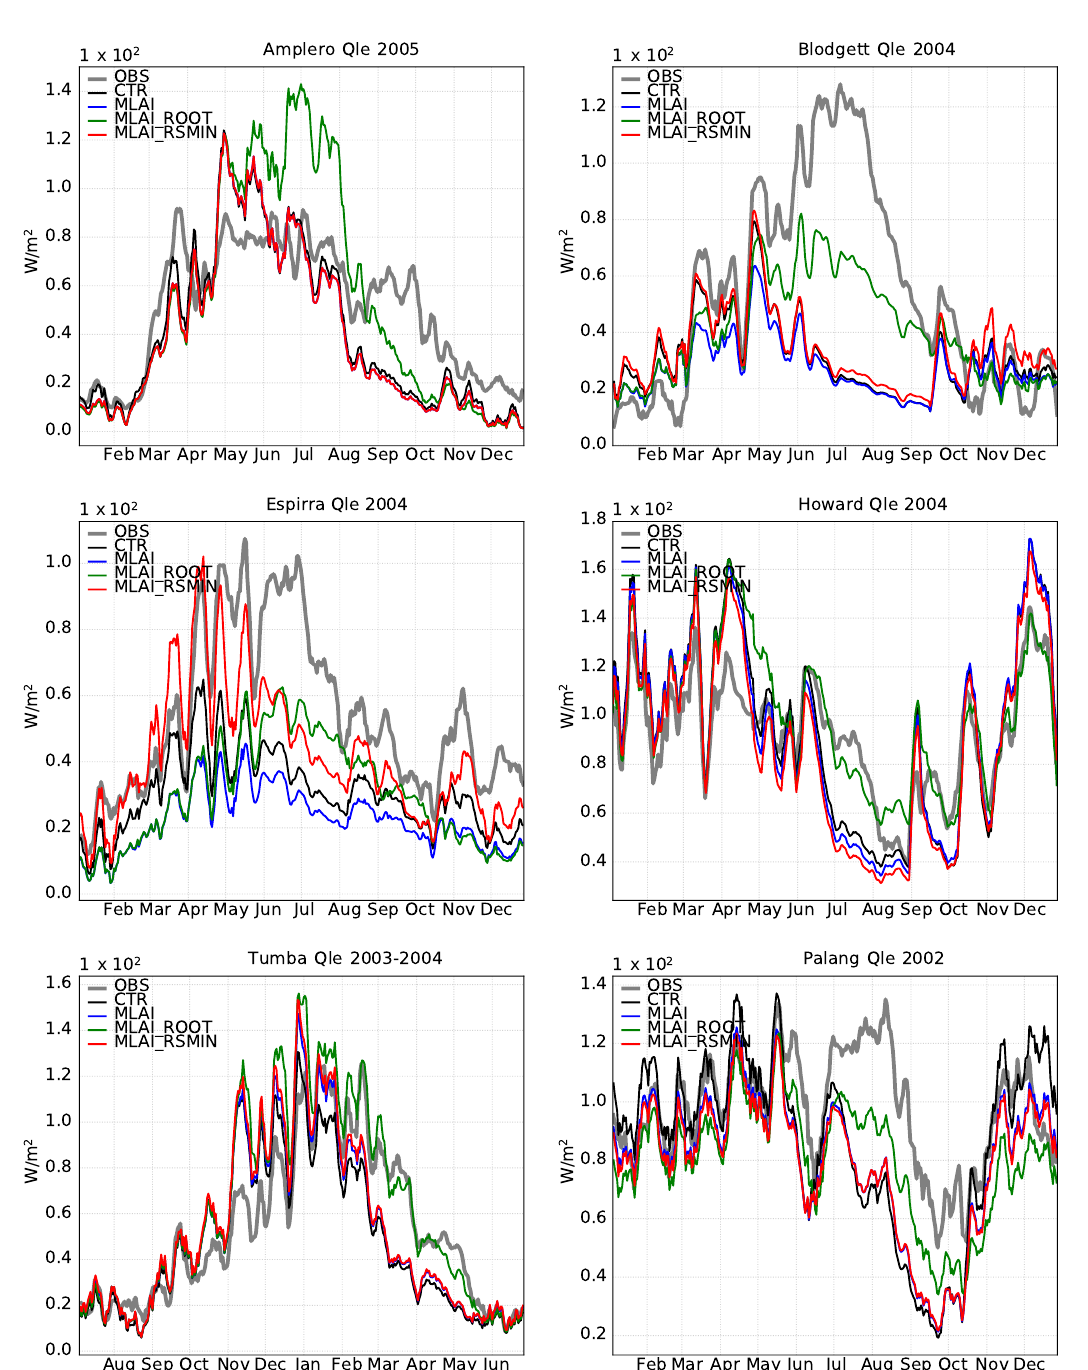
Figure 3. Simulated and observed latent heat flux during one example year with a 14 day running mean smoothing. Observations are in grey, CTR in black, MLAI in blue, MLAI_ROOT in green and MLAI_RSMIN in